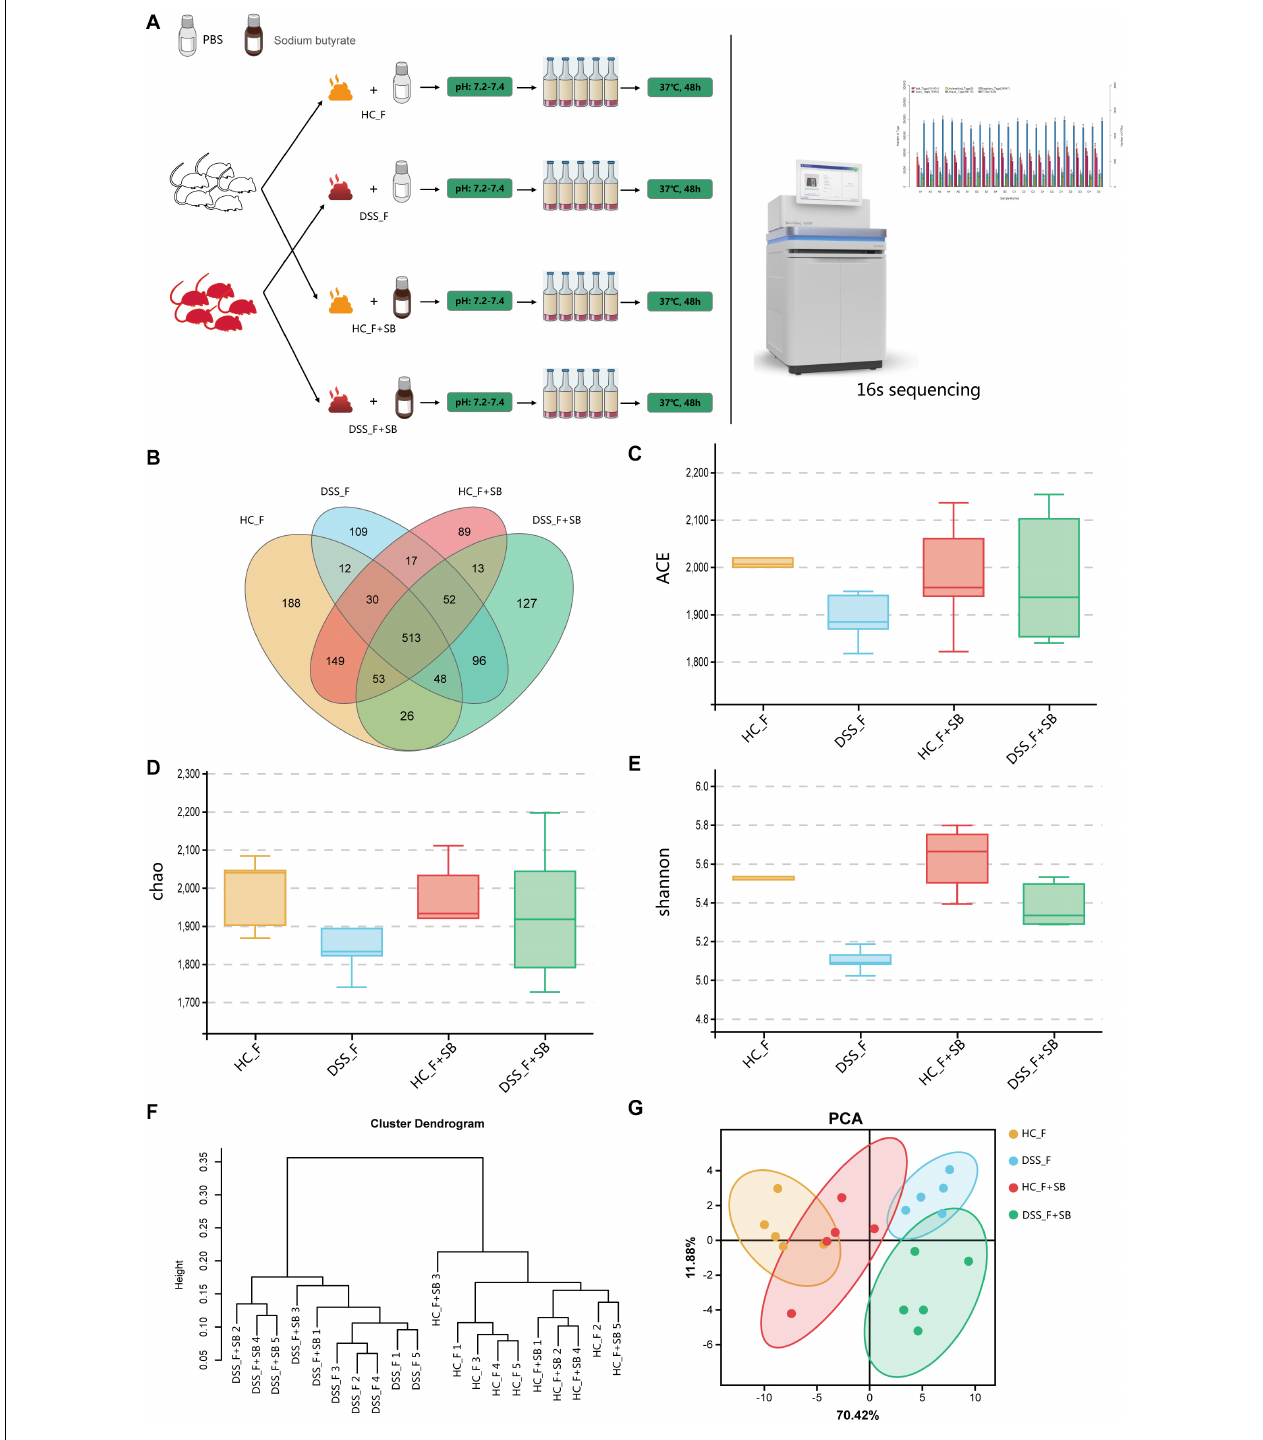
FIGURE 6 | Anaerobic culture with butyrate increases fecal microbial diversity in vitro . (A) Schematic diagram of the experimental design. The fecal samples were collected from healthy and colitis mice in an anaerobic condition and cultured in the specific media (pH 7.2–7.4) in the presence of sodium butyrate in an anaerobic condition for 48 h. The microbiota were analyzed by 16S sequencing. (B) Venn diagram. (C) ACE index. (D) Chao 1 index. (E) Shannon index. (F) UPGMA clustering tree. (G) PCA. HC_F: fecal samples from healthy mice were cultured without sodium butyrate; DSS_F: fecal samples from colitis mice were cultured without sodium butyrate; HC_F + SB: fecal samples from healthy mice were cultured with sodium butyrate; DSS_F + SB: fecal samples from colitis mice were cultured with sodium butyrate.